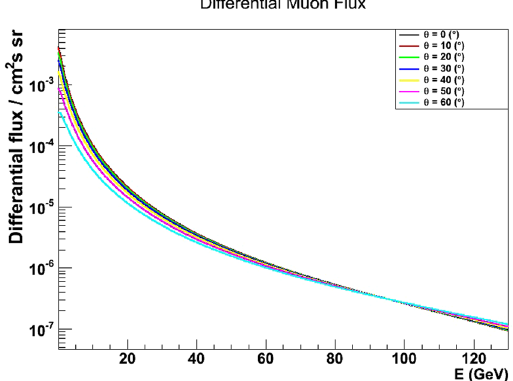
Figure 10. Differential muon flux distribution as a function of the muon energy, for different zenith angles, as given in ref. 22. The drawing was obtained using the software root